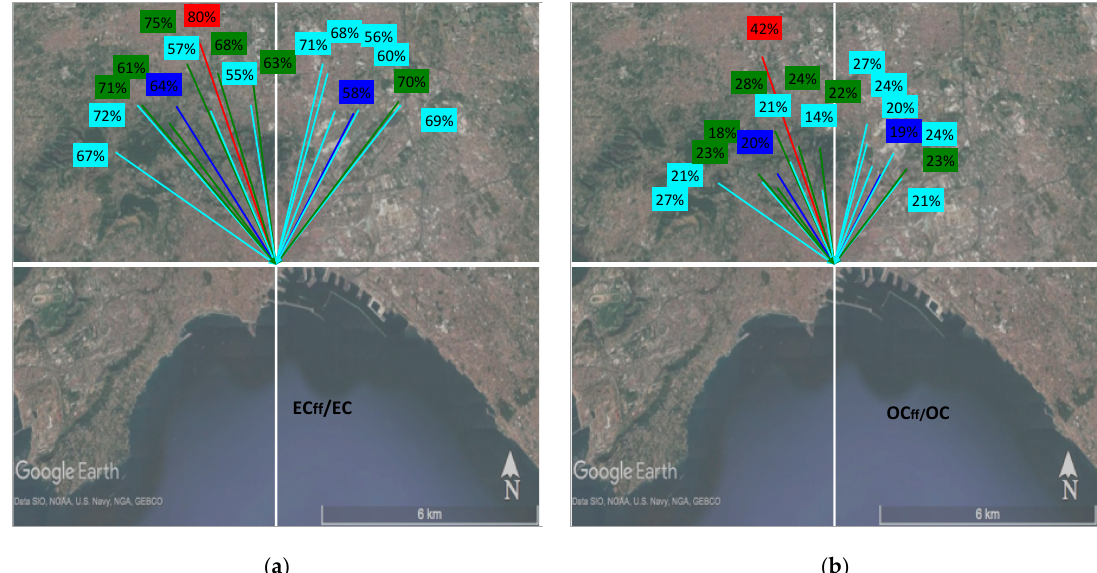
Figure 4. ( a ). The fossil share of EC projected along to the prevailing wind direction during the sampling time. Each vector lays on the average wind direction. Vector colors follow the origin code assigned according to back-trajectories and the length of each vector corresponds to the fossil fraction, given also in numbers. ( b ) As for Figure 4a, but for OC ff .